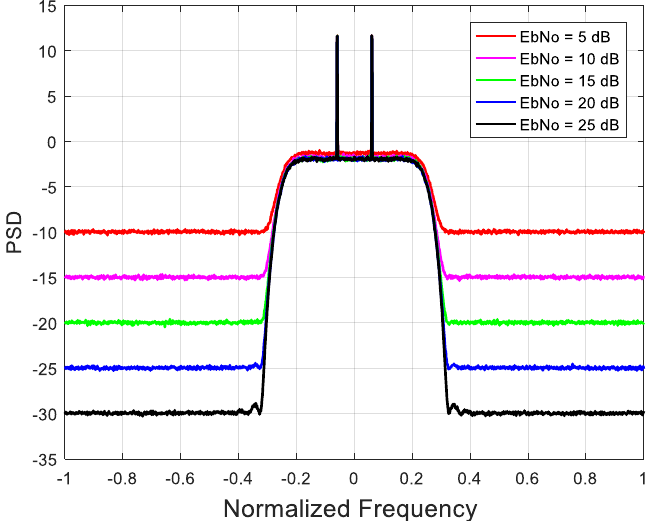
Figure 2. The received PS signal with various 𝑬 𝒃 𝑵 𝒐 ⁄ parameters